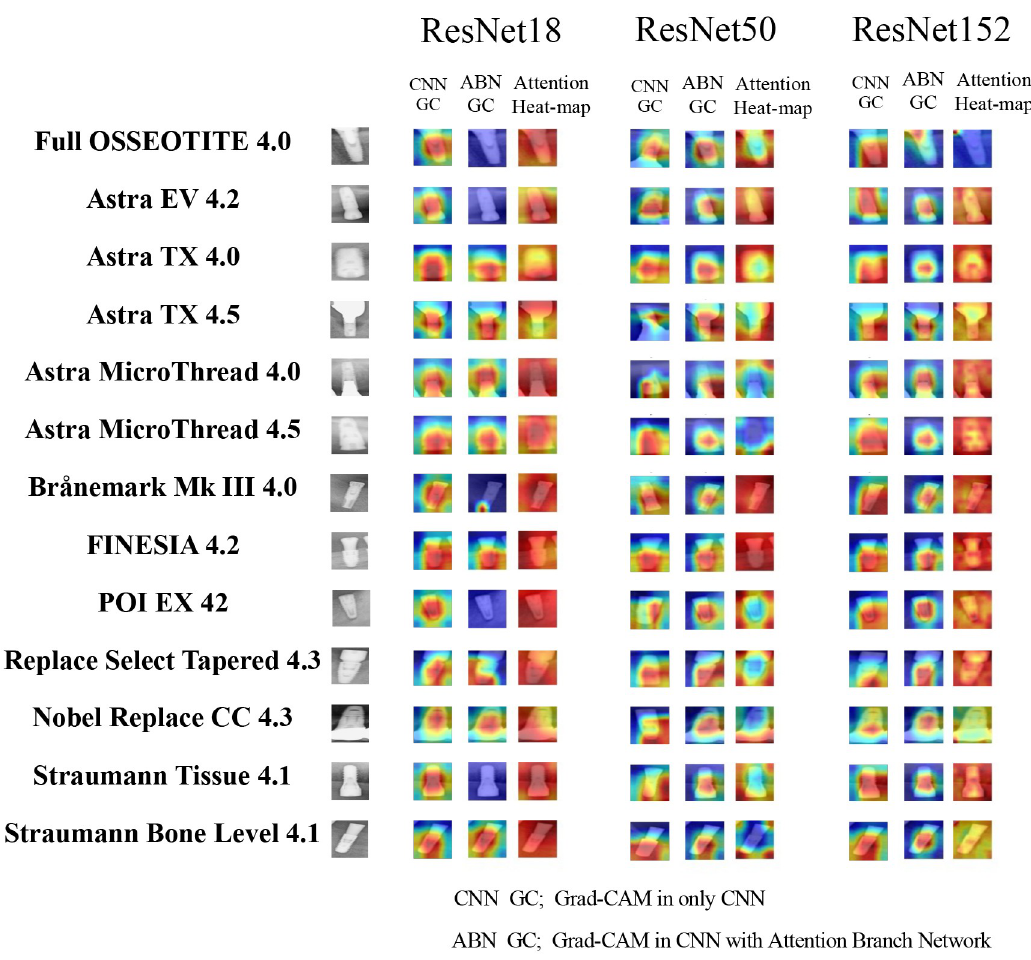
Fig 2. Visualization of the CNN’s region of interest using simple CNNs and ABNs with Grad-CAM and attention heatmaps.